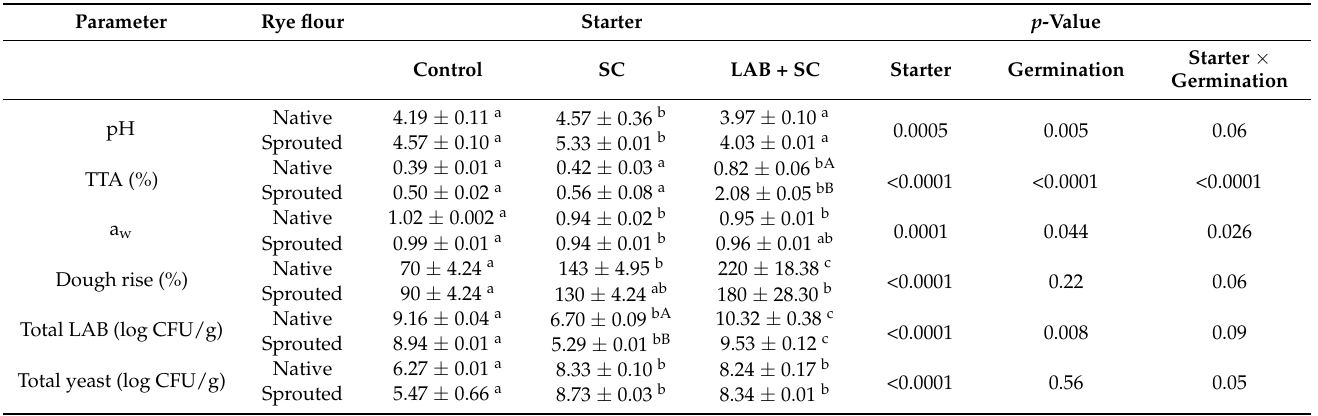
Table 1. Rye dough parameters measured after 24 h of